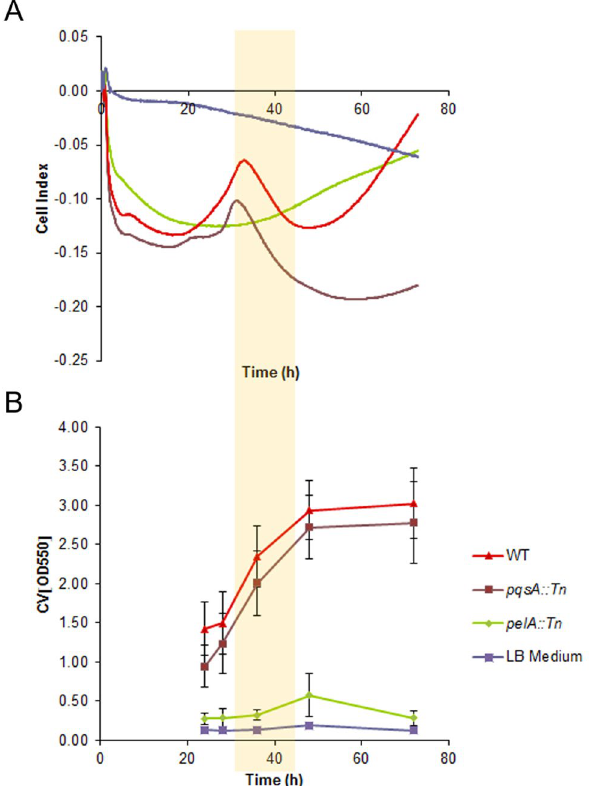
Figure 2. ( A ) Changes in the standardized single-frequency impedance (expressed as cell indices) and ( B ) crystal violet staining measurements of pellicle biofilm over 72 h, during biofilm growth in LB culture medium of PA14 wt, pqsA::Tn mutant, and pelA::Tn mutant (n = 24 for each mutant) and LB Medium (n = 8). The PA14 wild type and pqsA::Tn are biofilm formers; pelA::Tn does not form biofilm. n indicates the number of technical replicates. The period of linear decline of the cell index is highlighted by a yellow